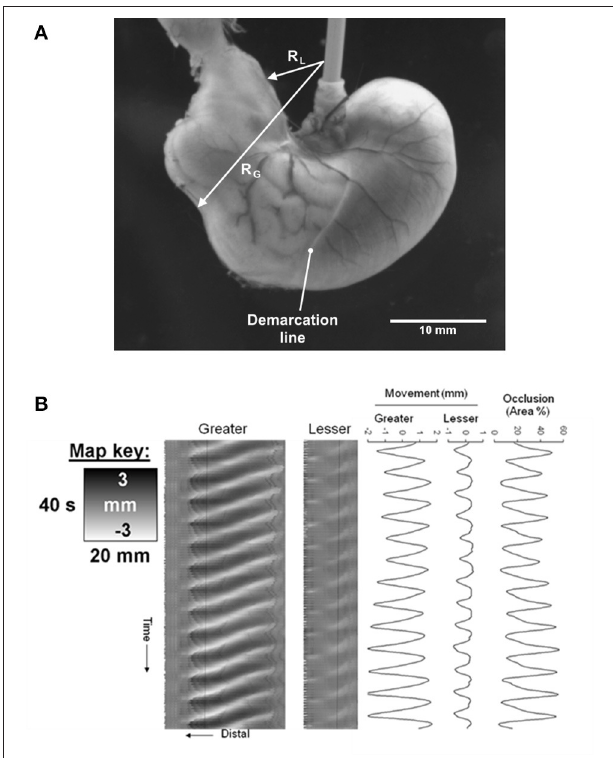
FIGURE 4 | D-type ST map of transit of gastric peristalses along an arc based near the greater curvature (abscissa) and centered at the anterior limit of the esophageal junction. (A) Diagram showing the basis of the arc of curvature from which spatio temporal maps are derived with the cumulative angle of deviation on the horizontal axis with the intensity proportional to the distance along the line between the lesser (RL) and greater (RG) curvatures with lighter shading for longer and darker shading for shorter distances. The scaling of the raw maps can be converted to linear distance from the pylorus to enable linear velocity to be quantified. (B) D-type ST map showing the rhythmic sequence of angled lighter bands of radial constriction from regular antral peristaltic events. The uniform thickness of the bands indicates they are of constant duration regardless of their position with respect to the pylorus. The uniformly linear trajectory angled toward the pylorus (on the left) indicates that their velocity of propagation is uniform along the arc of the LOI. Note that the darker area lying to the right of each propagating contraction is from dilatation from retropulsion of contents and that the extent of this distension decreases near the pylorus presumably from increased thickness and decreased compliance of the distal walls. Figure adapted from Lentle et al.